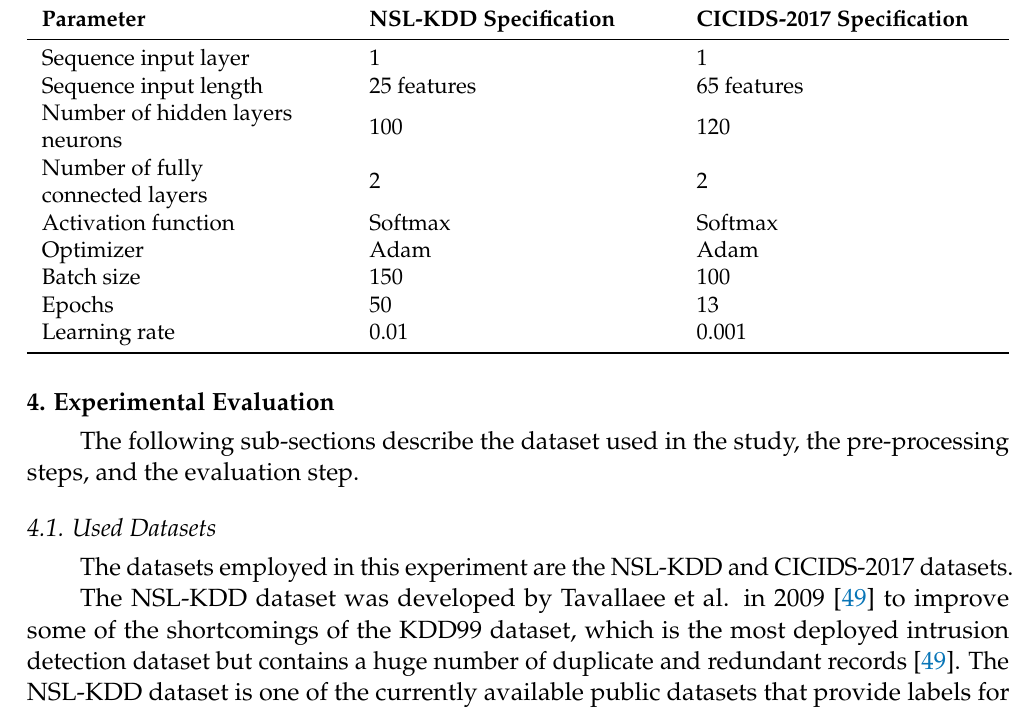
Table 1. RLSTM parameters.